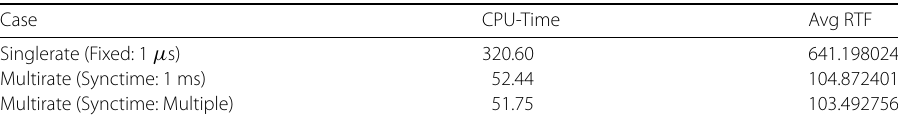
Table 2 Comparison of singlerate and multirate approach corresponding CPU-time and average real time factor for the three-phase inverter with cooling system simulation Case CPU-Time Avg RTF Singlerate (Fixed: 1 μ s) 320.60 641.198024 Multirate (Synctime: 1